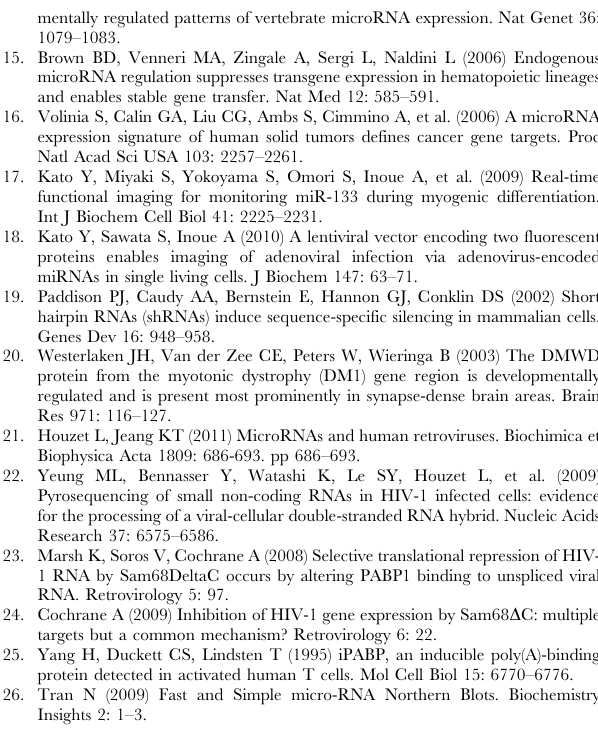
marked in red. Table S2 Sequences of probes used for northern